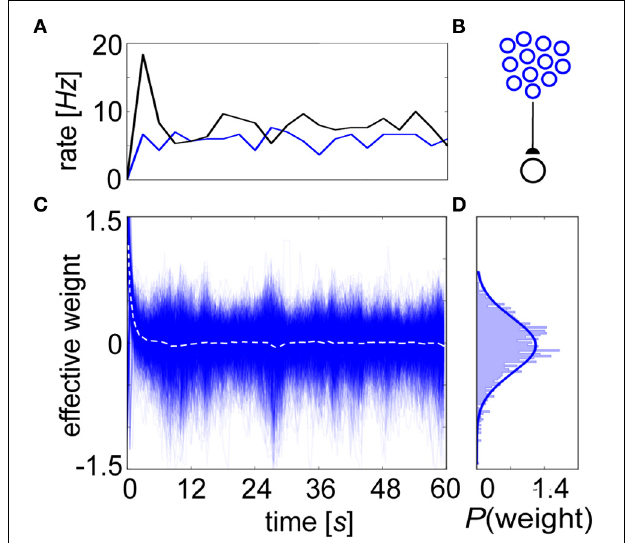
FIGURE 6 | The BCPNN learning rule exhibits a stable equilibrium weight distribution. (A) Progression of averaged rates of firing (3s bins) for the presynaptic (blue) and postsynaptic (black) neurons in the network. (B) Setup involves 1000 Poisson-firing presynaptic neurons that drive one postsynaptic cell. (C) The BCPNN synaptic strengths recorded every 100ms (blue, dotted white line is their instantaneous mean) has an initial transient but then remains steady throughout the entire simulation despite deviation amongst individual weights within the equilibrium distribution. (D) BCPNN weight histogram plotted for the final time epoch is unimodal and approximately normally distributed (blue line, μ 0 = 0 . 0 and σ 0 = 0 .